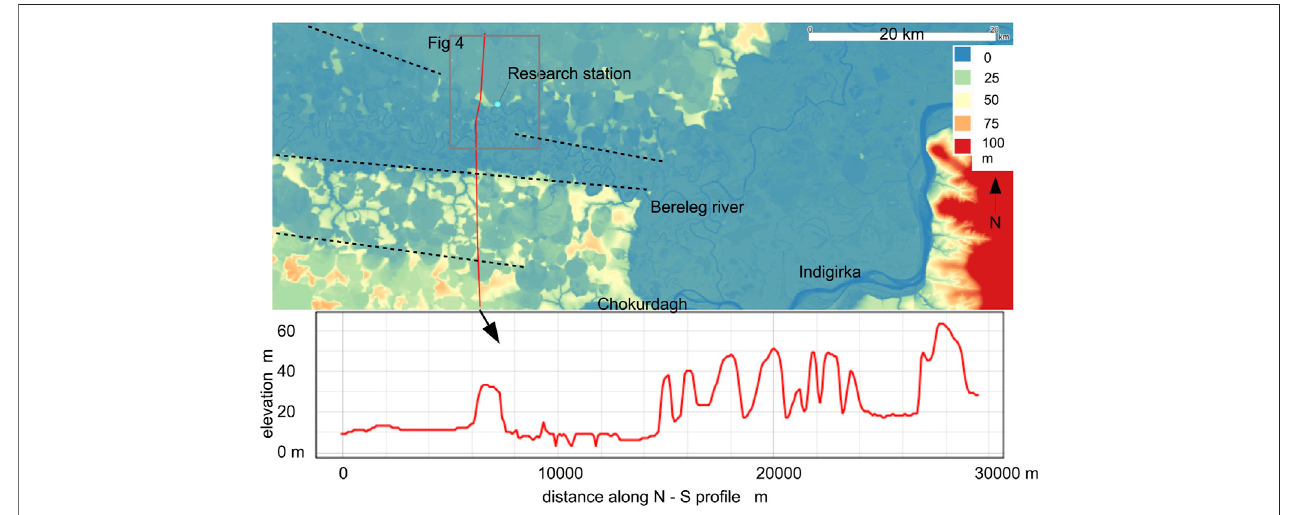
FIGURE 3 | Tandem-X elevation map of the study area and its surroundings. The elevation pro fi le (below) is situated slightly west from Kytalyk Tundra Research Station (blue dot). The grey square indicates the map area of Figure 4 . Broken black lines indicate possible tectonic lineaments.